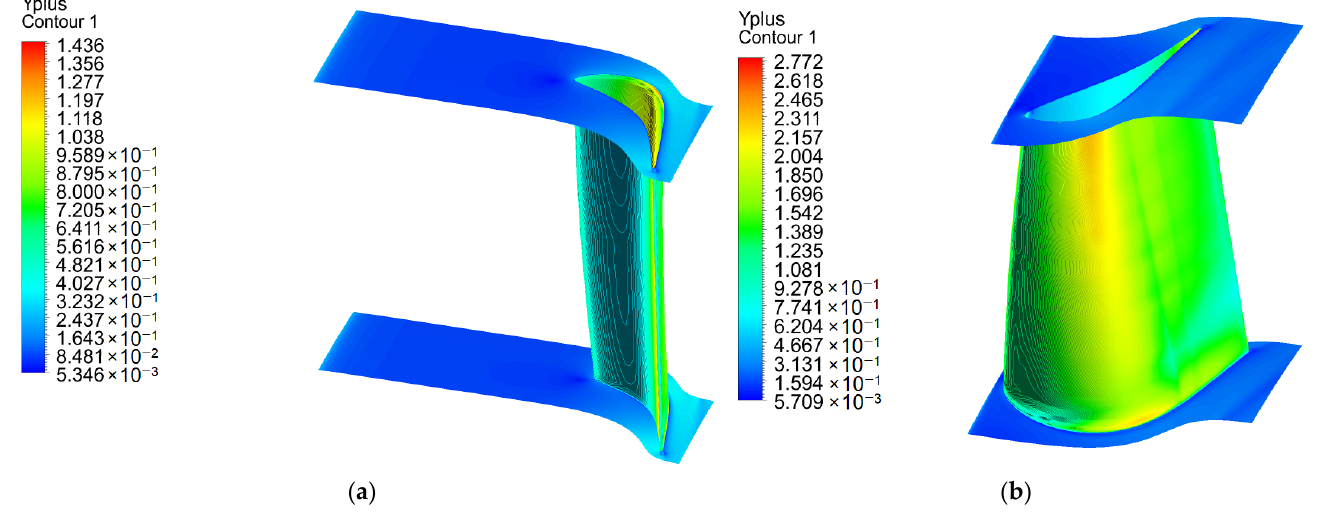
Figure 6. Contours of the y + parameter on: ( a ) nozzle; and ( b ) bucket.